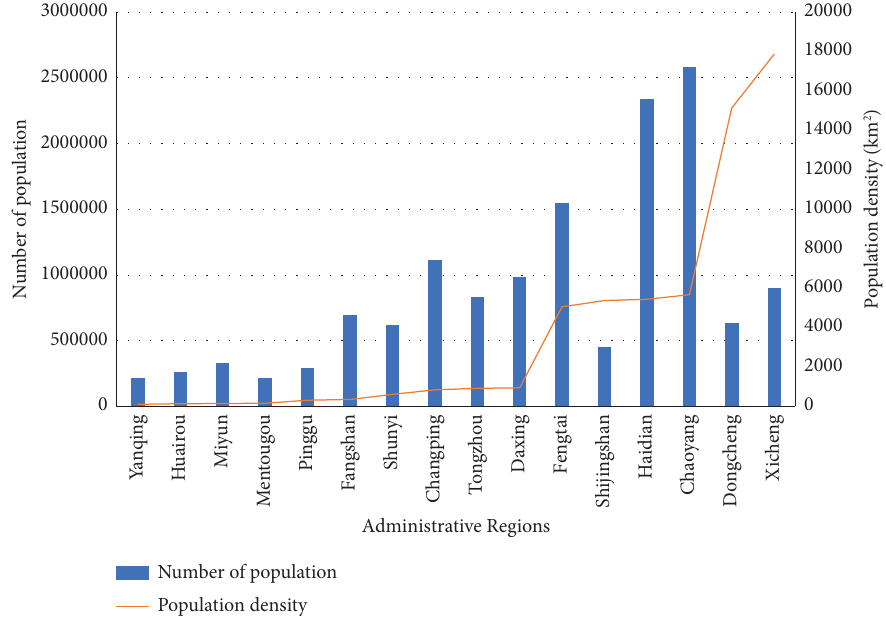
Figure 9: Population distribution by administrative regions in Beijing.